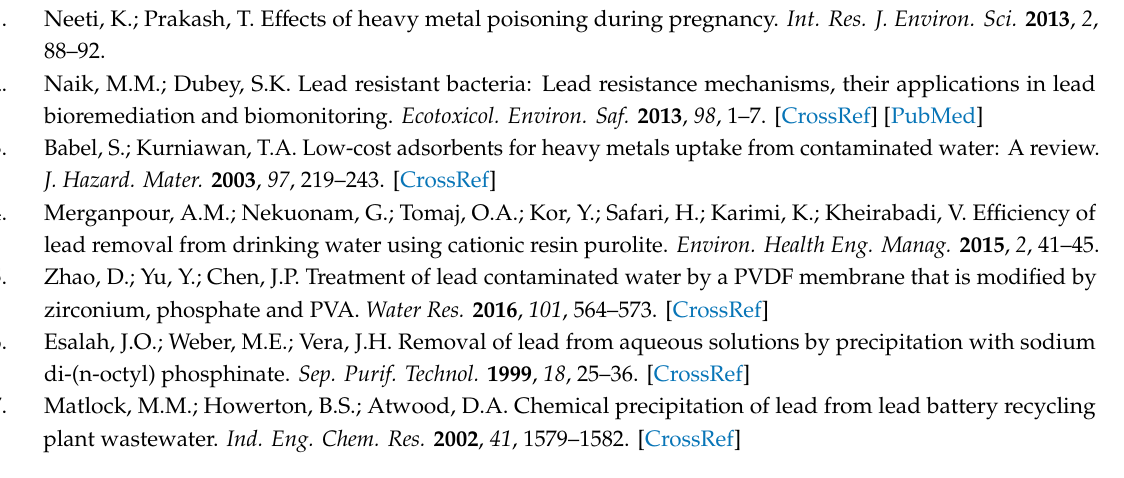
Figure S1: Phylogeny based on 16S rRNA sequences, showing the relationships between the Methylobacterium hispanicum EM2 strain and other members of the Methylobacterium genus. The numbers at the nodes indicate the level of bootstrap support based on the neighbor-joining analysis of 1000 replicates. The accession numbers are given in parentheses. Bar = 0.01 substitutions per nucleotide position; Figure S2: Investigation of the resistance of the EM2 strain to di ff erent metals. (a) Analysis of the minimal inhibitory concentrations (MICs) of various metal ions. (b) Growth profile of the EM2 strain under di ff erent PbCl 2 concentrations. The values and error bars represent the means ± standard deviation ( n = 3). Figure S3: Linearization plots of the biosorption isotherms and kinetics of the EM2 strain. (a) Langmuir and (b) Freundlich isotherms, and (c) pseudo-first-order and (d) pseudo-second-order kinetic models. The values and error bars represent the means ± standard deviation ( n = 3). Table S1: Phenotypic characteristics of the Methylobacterium hispanicum EM2 strain; Table S2: Pb(II) removal from sewage water by the EM2